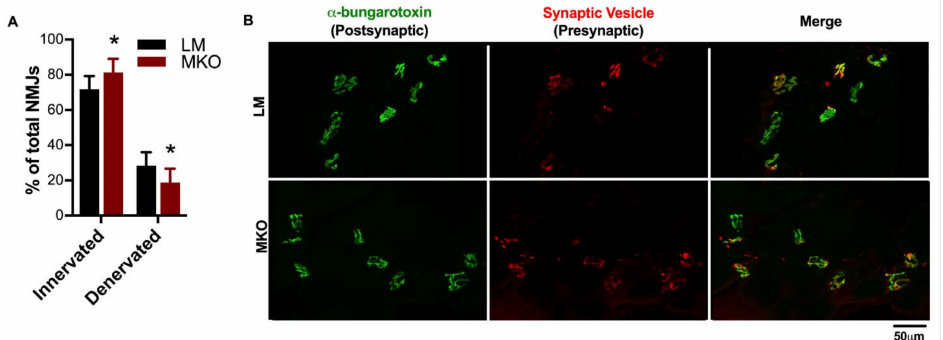
Figure 4. Neuromuscular junction integrity changes with lifelong Ulk1 deficiency. ( A ) Average number of innervated and denervated neuromuscular junctions (NMJs) in the diaphragm of MKO and LM mice ( p = 0.0227). Data are presented as mean ± SD. * = significantly different from LM. ( B ) Representative images of the pre- (red) and post-synaptic (green) terminals of the NMJs from both MKO and LM diaphragm muscle sections. The merged image depicts both innervated (yellow) and denervated (green) NMJs. Innervation was defined as the overlap of pre- and post-synaptic structures, while the complete or partial absence of the presynaptic terminal classified the NMJ as